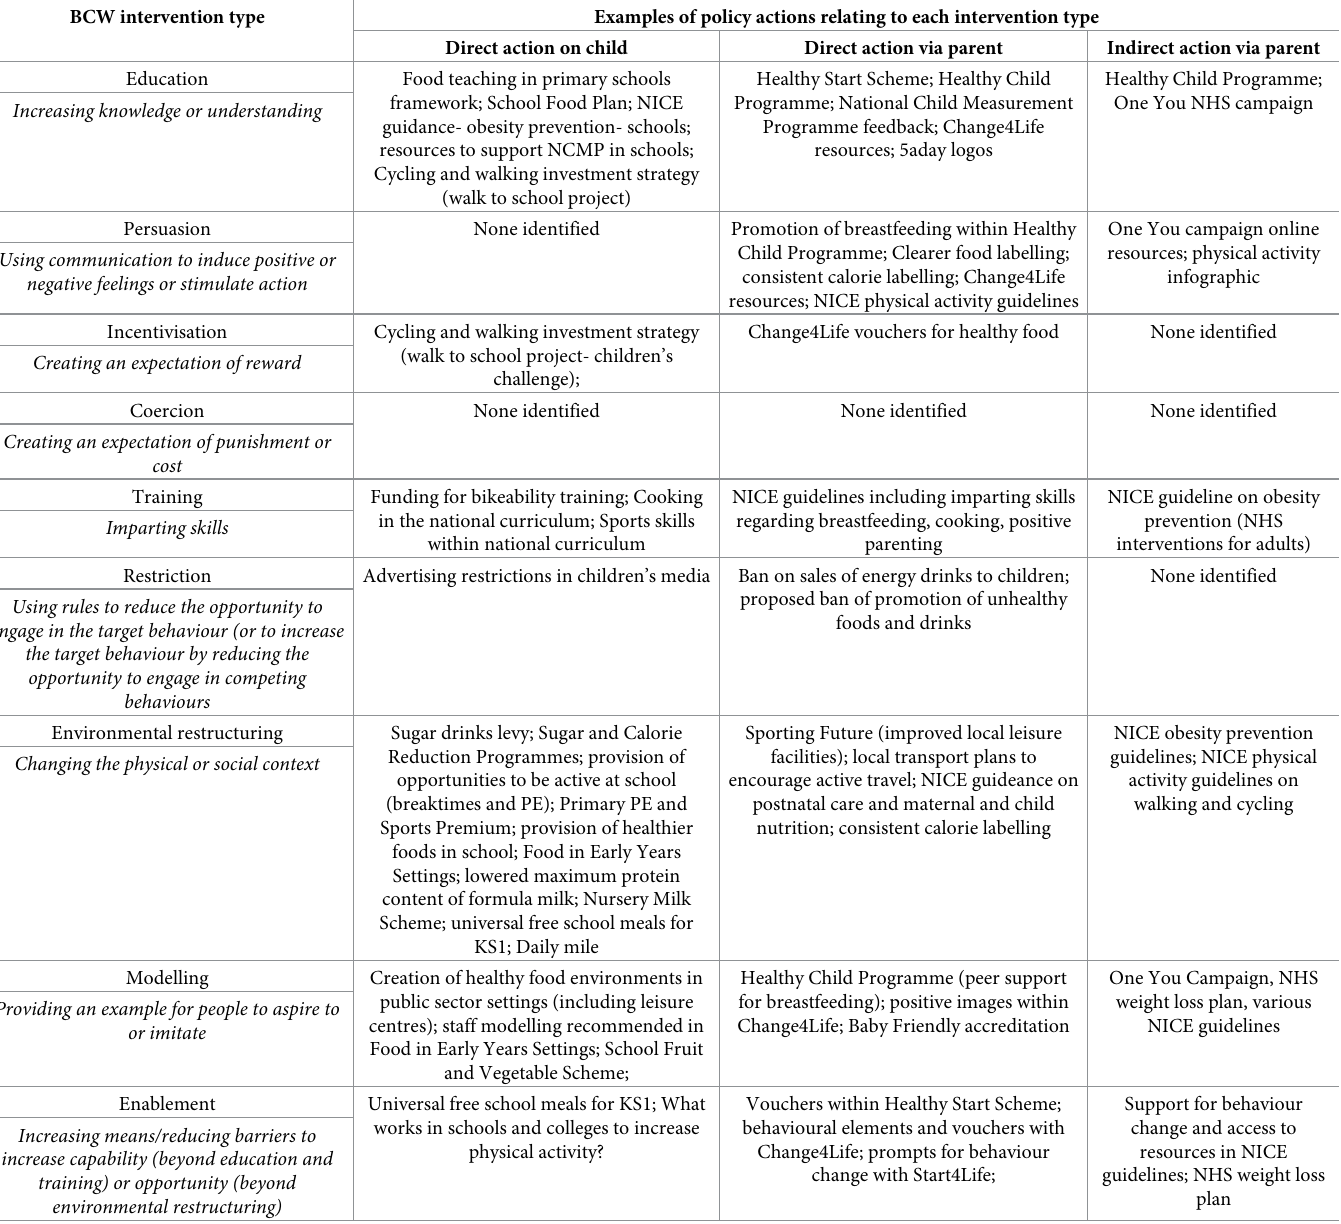
Table 3. Examples of how identified policy actions relate to BCW intervention